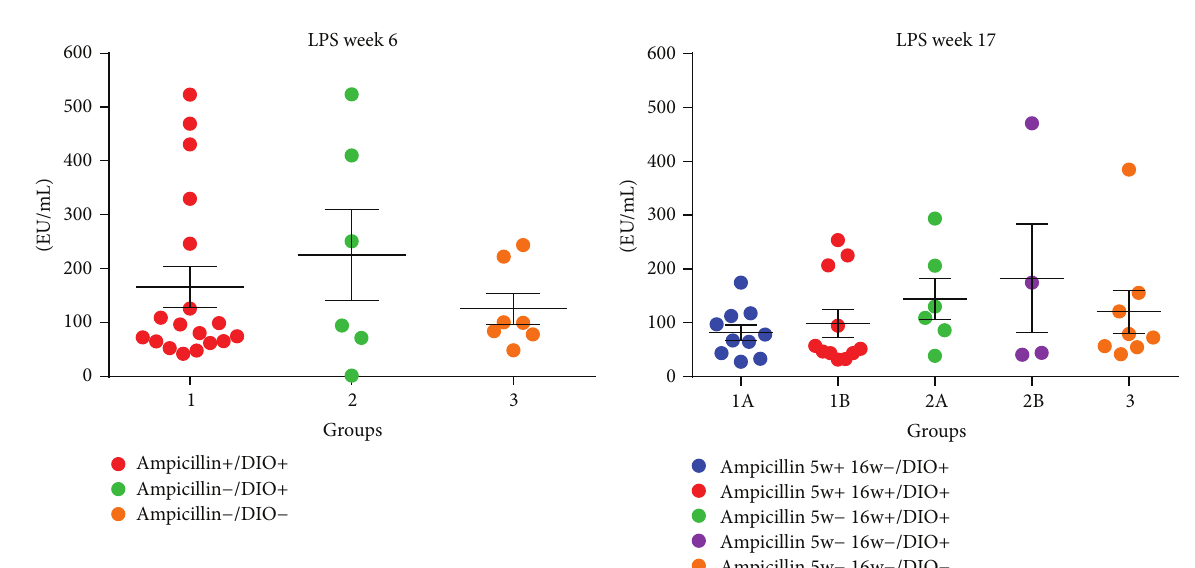
Figure 4: Lipopolysaccharide (LPS, mean, and SEM) levels in plasma were measured at six weeks of age and again at 17 weeks of age. At no point in time a statistically significant difference was present between the